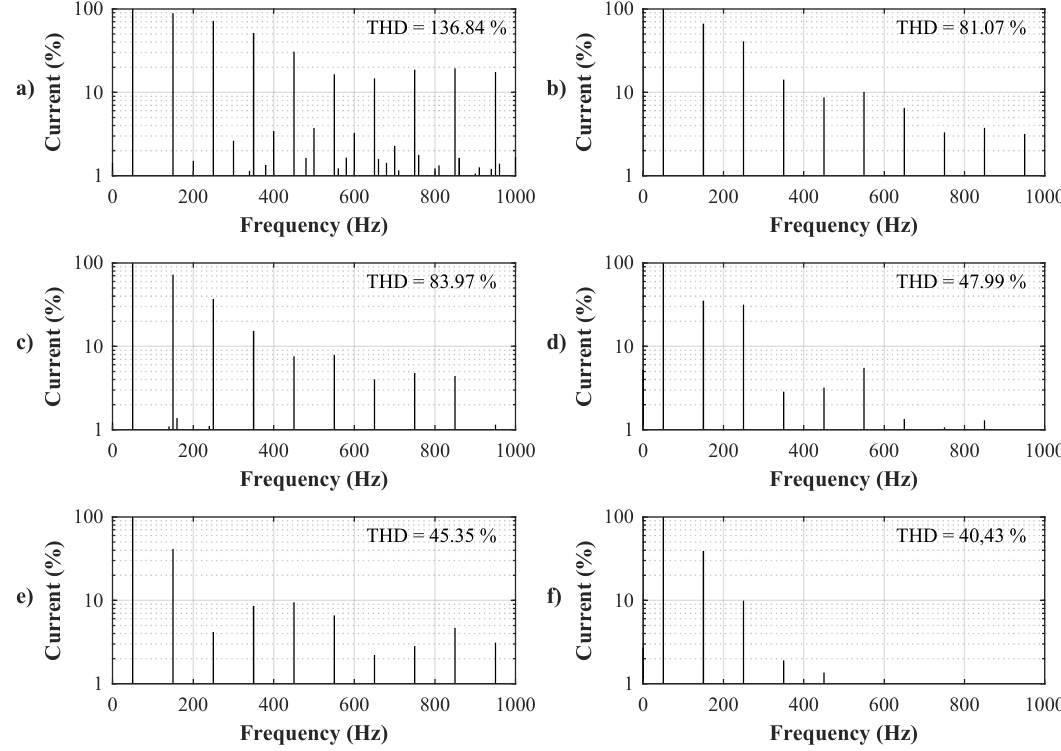
Figure 10. FFT of the individual loads; ( a ) PC source without PFC, ( b ) HI-FI amplifier on, ( c ) PC source with passive PFC, ( d ) HI-FI amplifier in standby mode, ( e ) PC source with active PFC, ( f ) audio-tape